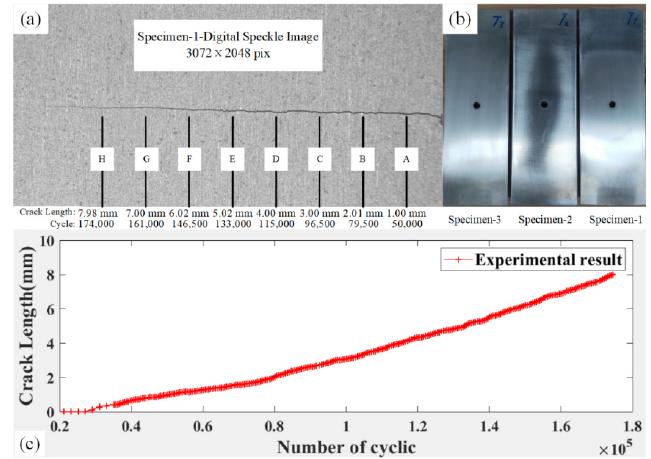
Figure 4. ( a ) Crack propagation path and speckle image; ( b ) manufactured specimen; ( c ) the crack growth curve.